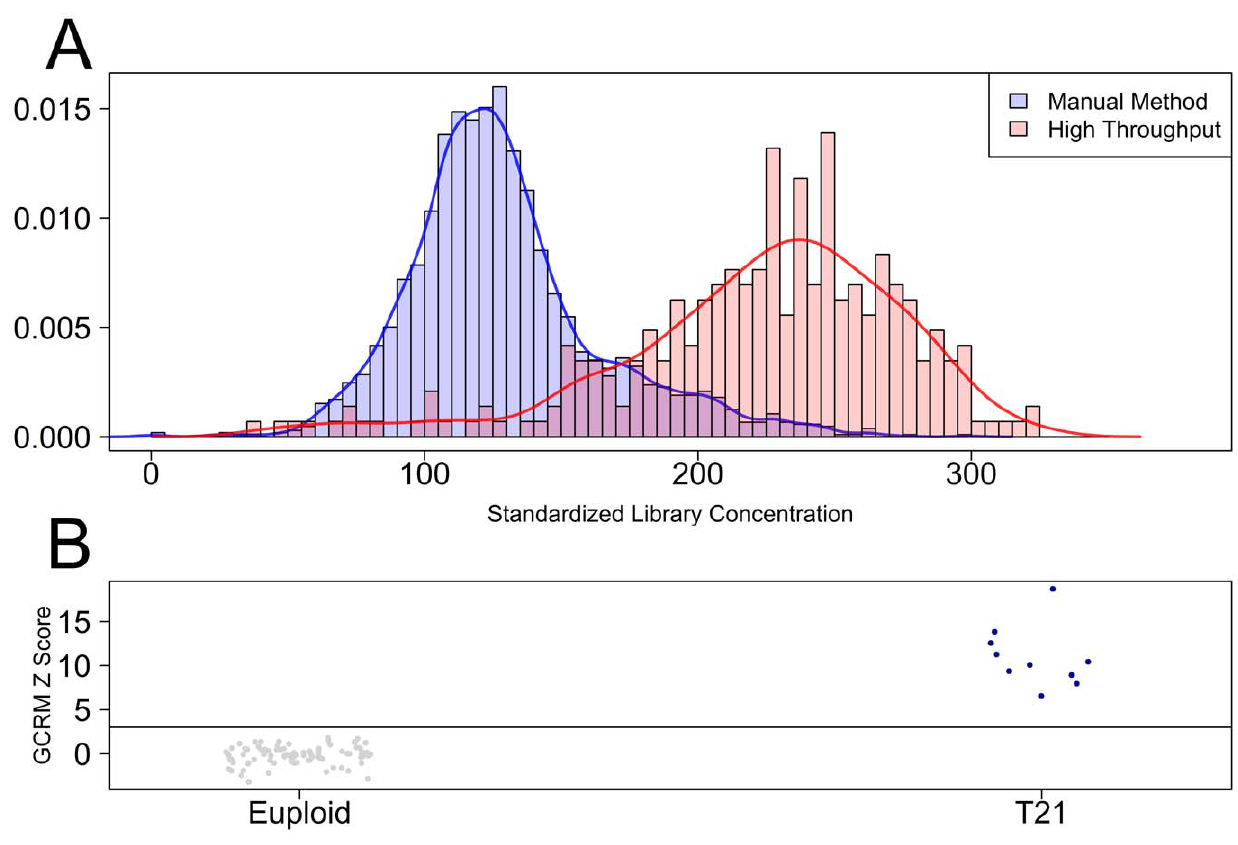
Figure 1. Library preparation optimization. A) The standardized library concentration was compared between semi-automated (n=287) and manual library preparation methods. B) GCRM based z-scores are shown for each of 93 samples. Confirmed euploid samples (n=83) are shown in gray; confirmed trisomy 21 samples (n=10) are shown in blue.